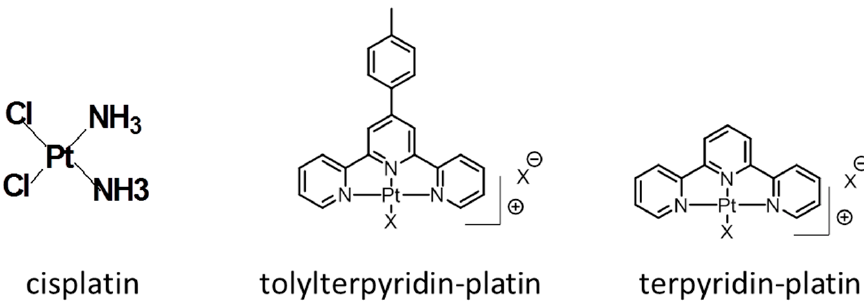
Figure 1. Chemical structures of cisplatin (cis-Pt), toly-terpyridin-platin, Pt-ttpy, and terpyridin-platin, Pt-tpy.